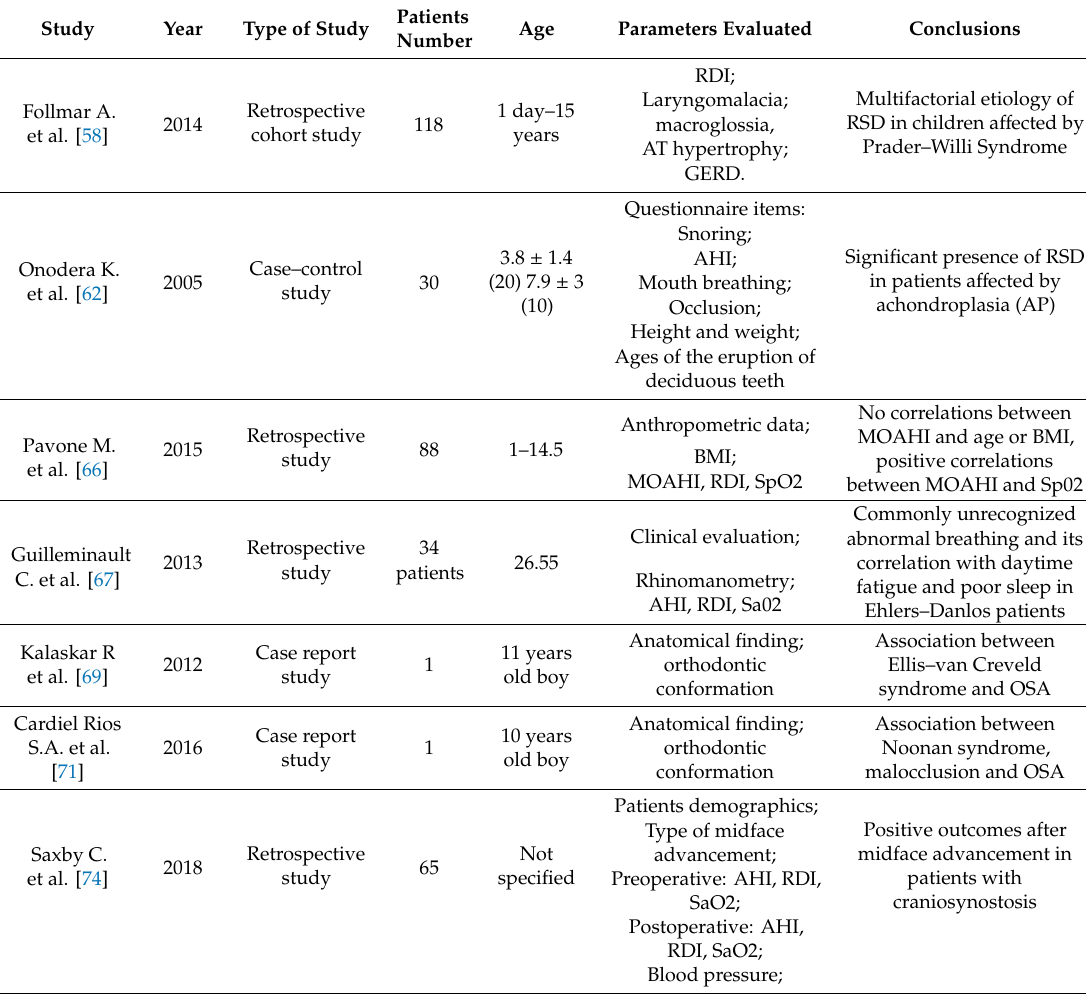
Table 5. Studies that have analyzed craniofacial abnormalities and genetics as a pediatric OSA risk